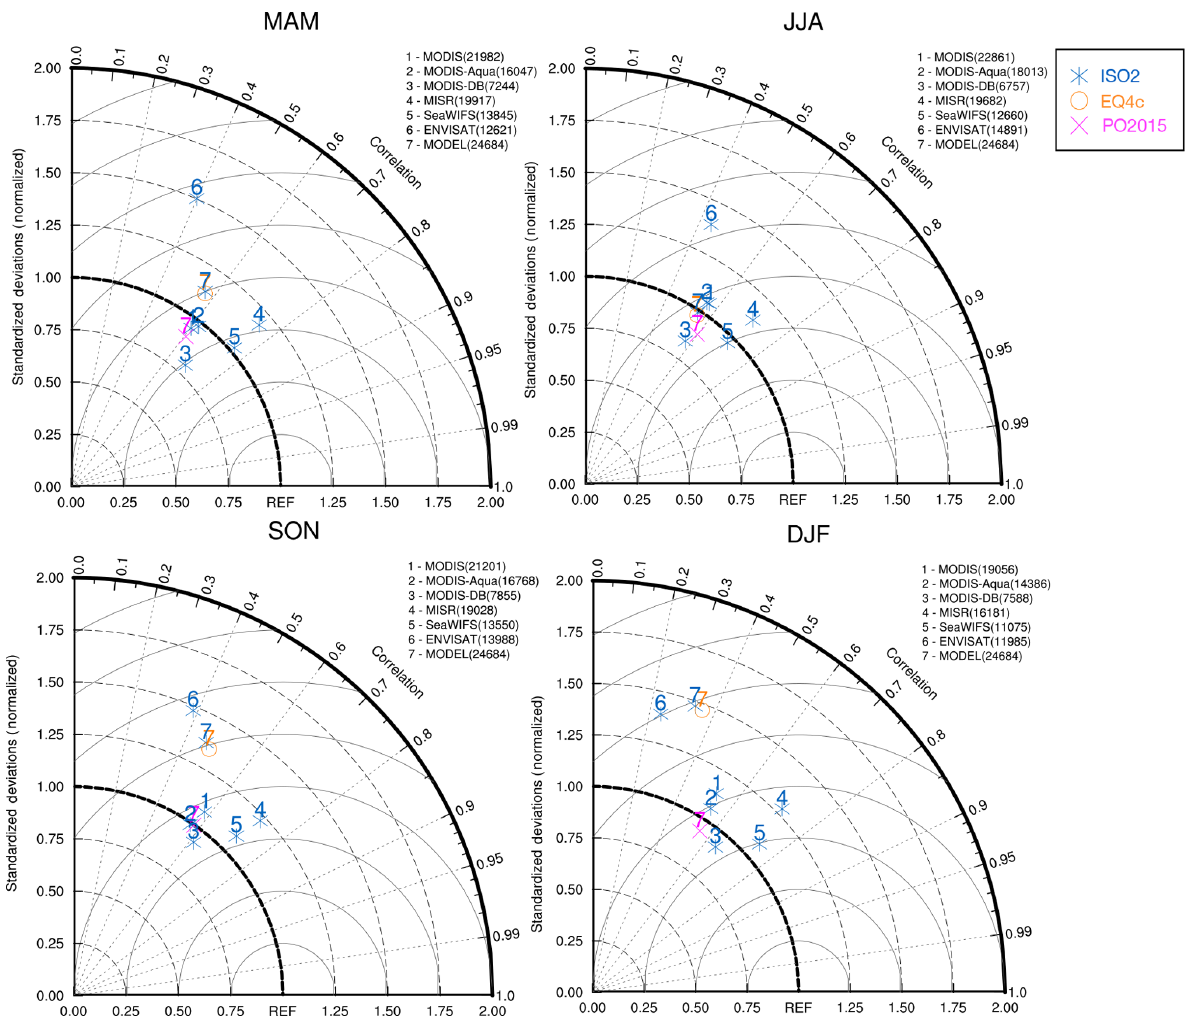
Figure 3. Taylor diagram for satellite and model AOD (2000–2010 mean). MODIS (1), MODIS-Aqua (2), MODIS-Deep Blue (3), MISR (4), SeaWIFS (5), ENVISAT (6), and models (7), i.e., ISORROPIA II (ISO2), EQSAM4clim (EQ4c), Pozzer et al. (2015) (PO2015), versus AERONET observations for the four seasons: spring (MAM), summer (JJA), autumn (SON), and winter (DJF). The number of observational points used in the seasonal analysis are shown in